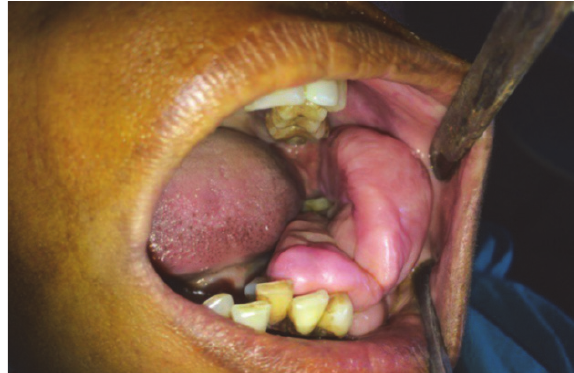
Figure 1: Intraoral preoperative lesion.